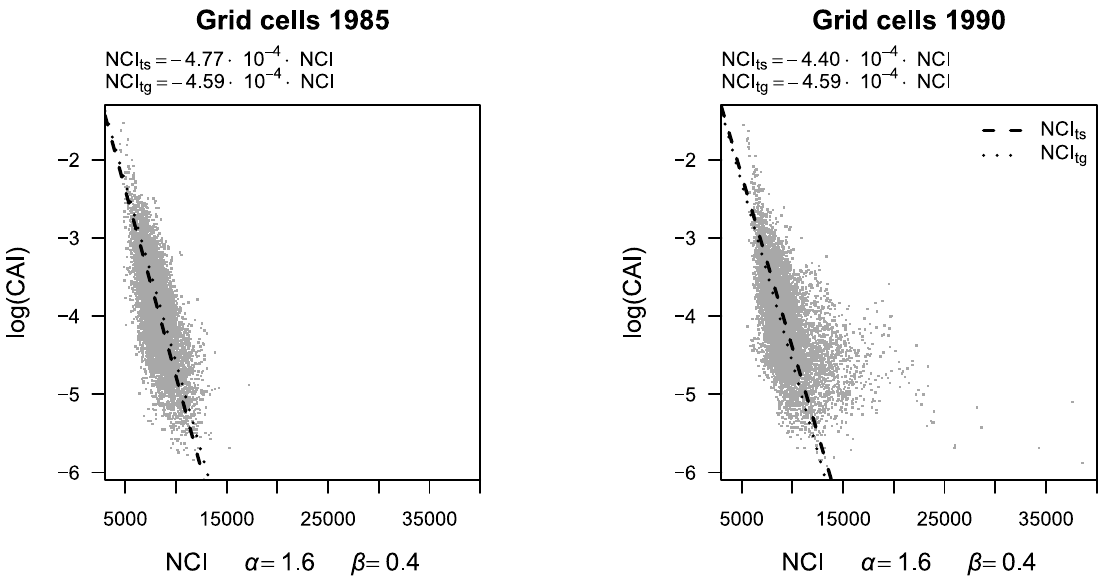
Figure 2. Best neighborhood competition index (NCI, a =1.6, b =0.4) versus canopy index (CAI). Lines show quantile regressions to convert neighborhood competition index (NCI) into an interval-specific estimate of log(canopy index) (NCI ts , dashed line) or into a general estimate of log(canopy index) which is based on pooled data from both census intervals (NCI tg , dotted line).